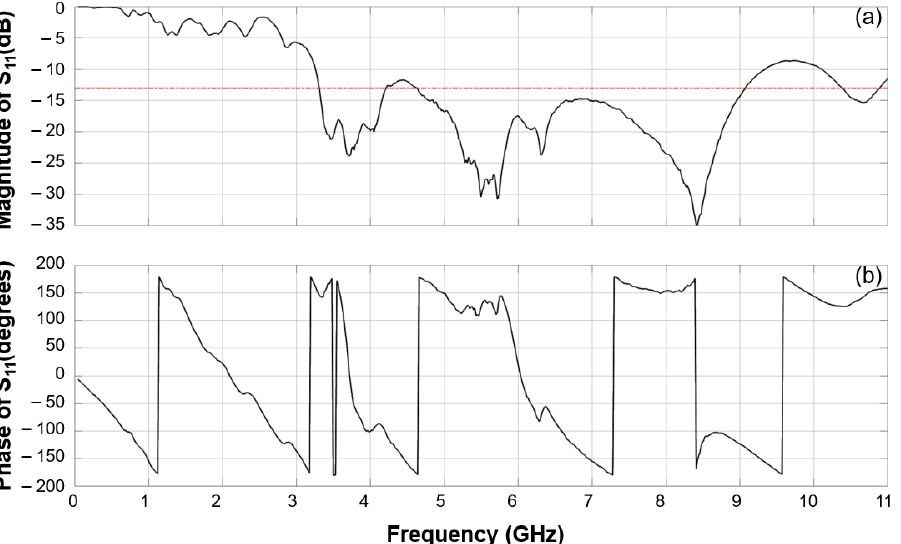
Figure 8. Magnitude and phase of S 11 parameter of the Low-Cost monopole UWB antenna used in the experimental setup:( a ) S 11 magnitude, the red plot indicates the − 13 dB threshold, values smaller than this value are preferred. ( b ) S 11 phase.